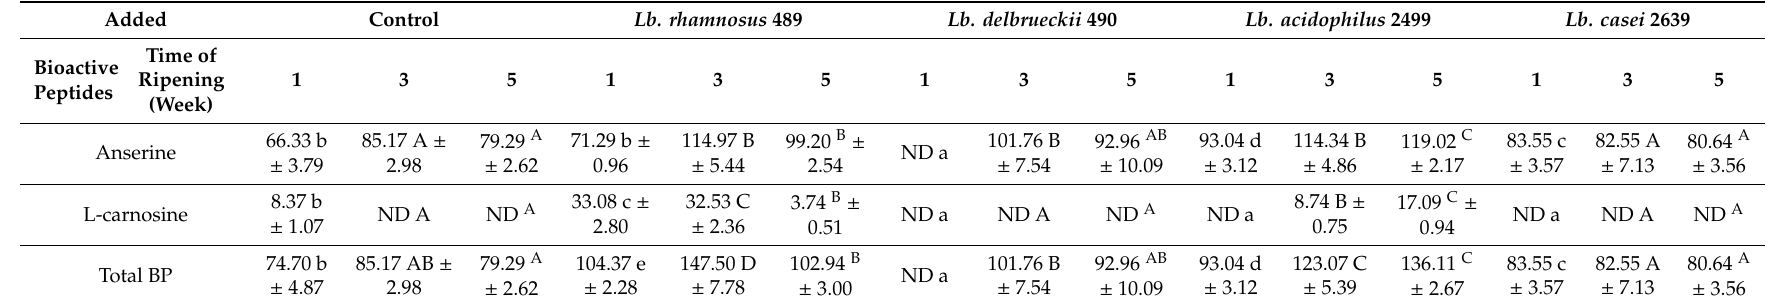
Table 3. Concentration of bioactive peptides (BP) in Dutch-type cheese models during ripening (mg kg − 1